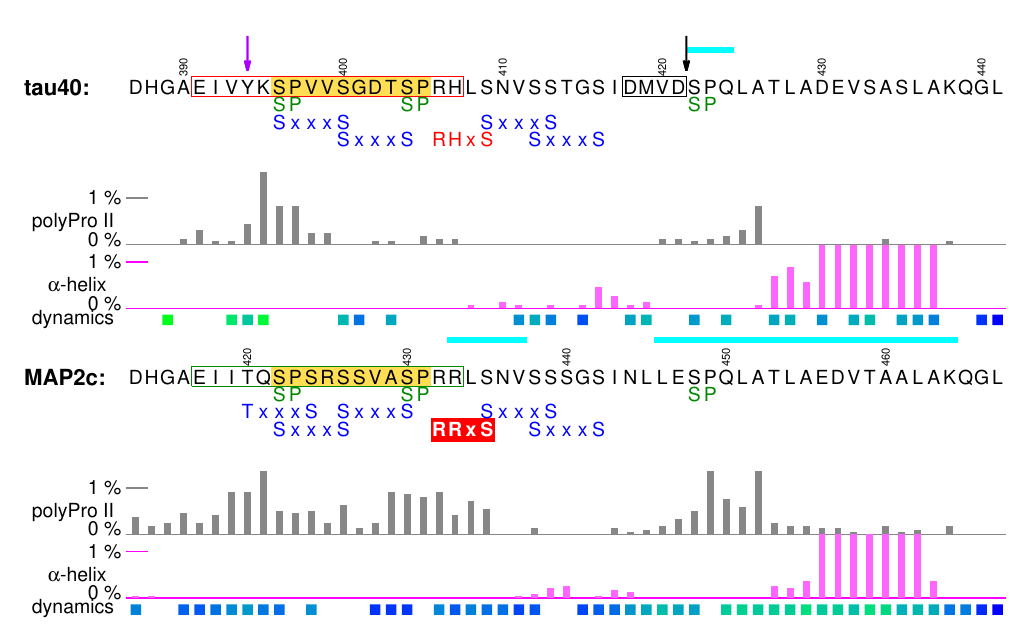
Figure 7. C-terminal sequences of human tau40 and rat MAP2c. The region of tau interacting with cholinergic muscarinic receptors M1 and M3 is shown in the red frame, and the corresponding region of MAP2c is shown in the green frame. The PHF-1 epitope of tau40 is shown in the yellow box and the MAP2c site phosphorylated most rapidly by PKA is shown in the red box. The black frame and the black arrow mark the caspase-3 recognition sequence and cleavage site, respectively. Other symbols are used as described for Figures 3 and